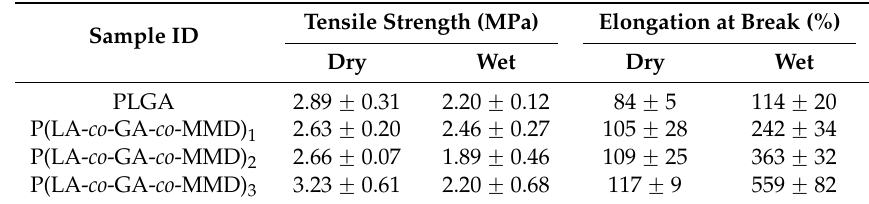
Table 2. Mechanical properties of PLGA and P(LA- co -GA- co -MMD) scaffolds under dry and wet